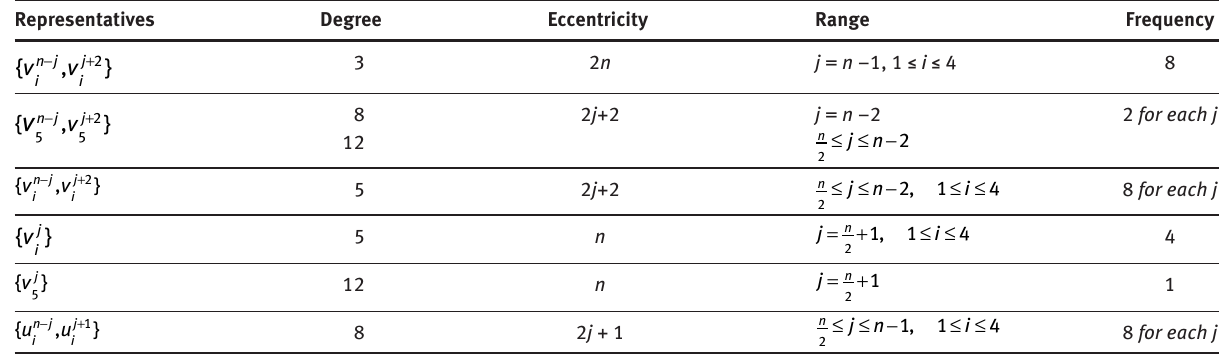
Table 1: Eccentricity and degree based vertex partition of FCC ( n ) for n ≡ 0(mod2)